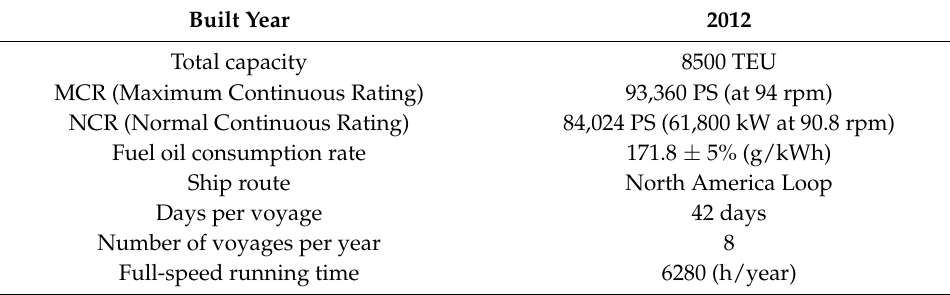
Table 2. Particulars of container Vessel U.